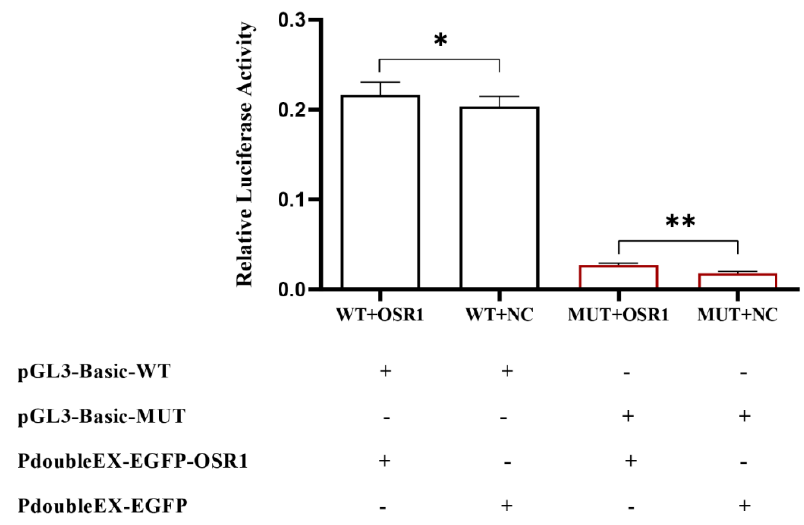
Figure 7. Effects of the transcription factor OSR1 overexpression on the CXCL11 gene promoter rel- ative luciferase activity; * p < 0.05 and ** p < 0.01.